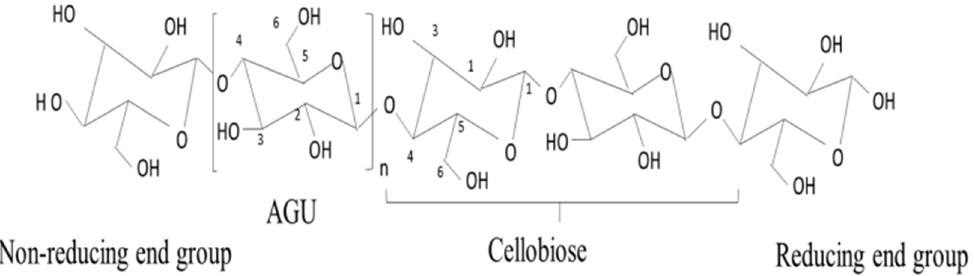
Figure 2. Structural representation of cellulose polymer [5 8 ].